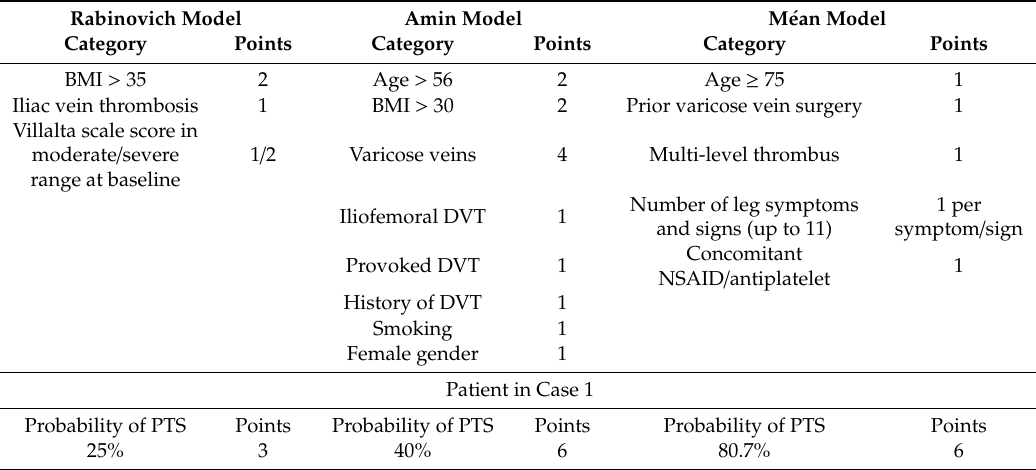
Table 1. Post-thrombotic syndrome (PTS) risk prediction models. BMI—body mass index; NSAID— non-steroidal anti-inflammatory drug; DVT—deep vein thrombosis. Rabinovich model: 0